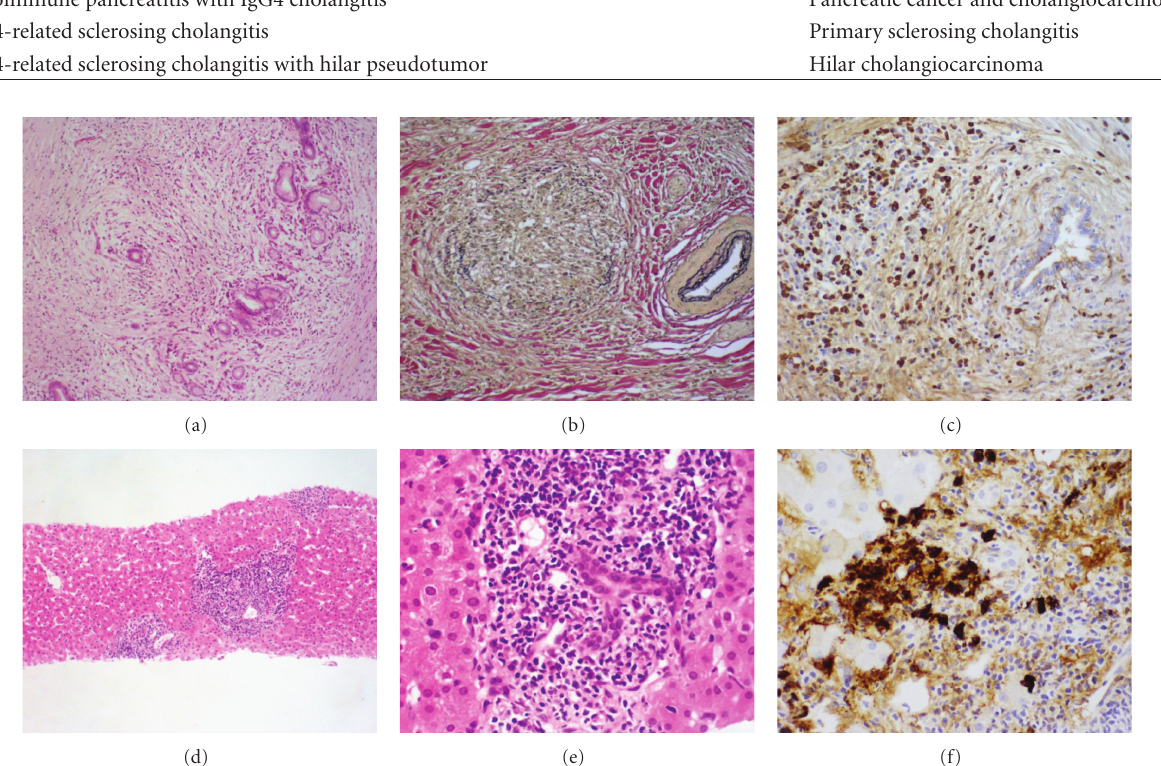
Figure 1: Histopathology of IgG4-related sclerosing cholangitis. The surgical specimens show di ff use inflammatory cell infiltration with fibrosis involving peribiliary glands (a), obliterative phlebitis (b), and infiltration of many IgG4 + plasma cells (c). The liver needle biopsy reveals portal inflammation (d), bile duct damage (e), and IgG4 + plasma cells (f).